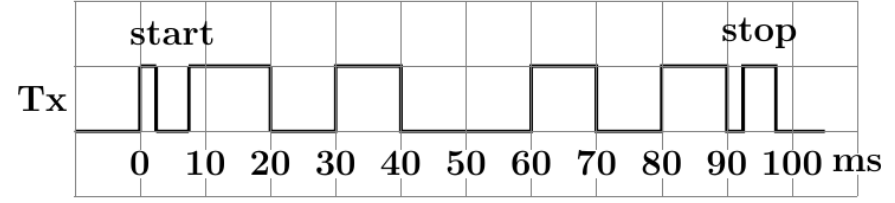
Figure 13. Tx line visualised: sending 0xA5 (LSB to